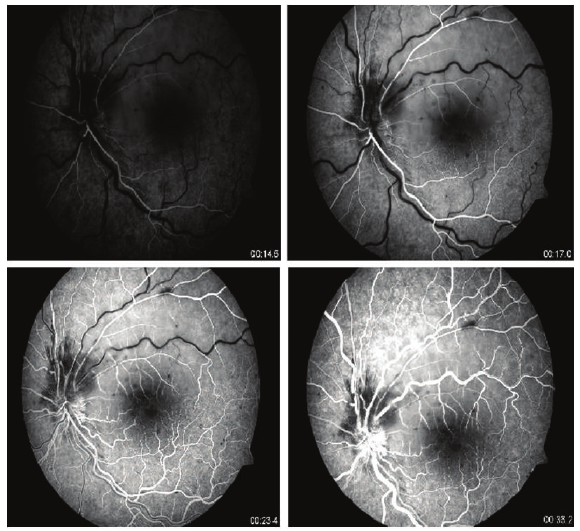
Figure 3: Delayed filling of the affected artery and hypofluorescence in the surrounding retina on FFA. Numbers indicate seconds.